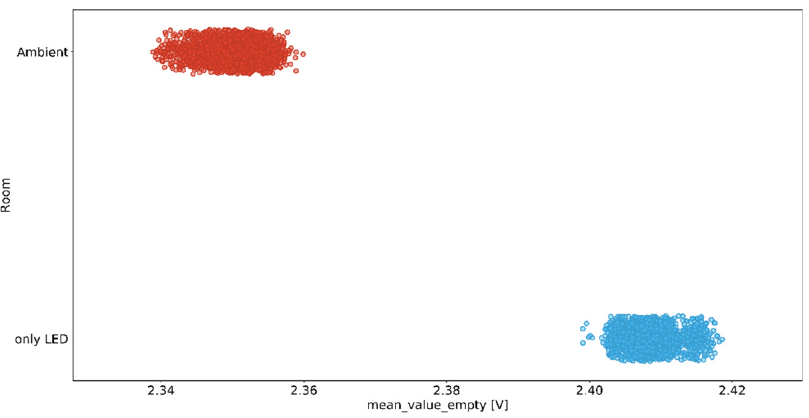
Figure 9. Scatter plot of the calculated mean values during the known absence of the train.